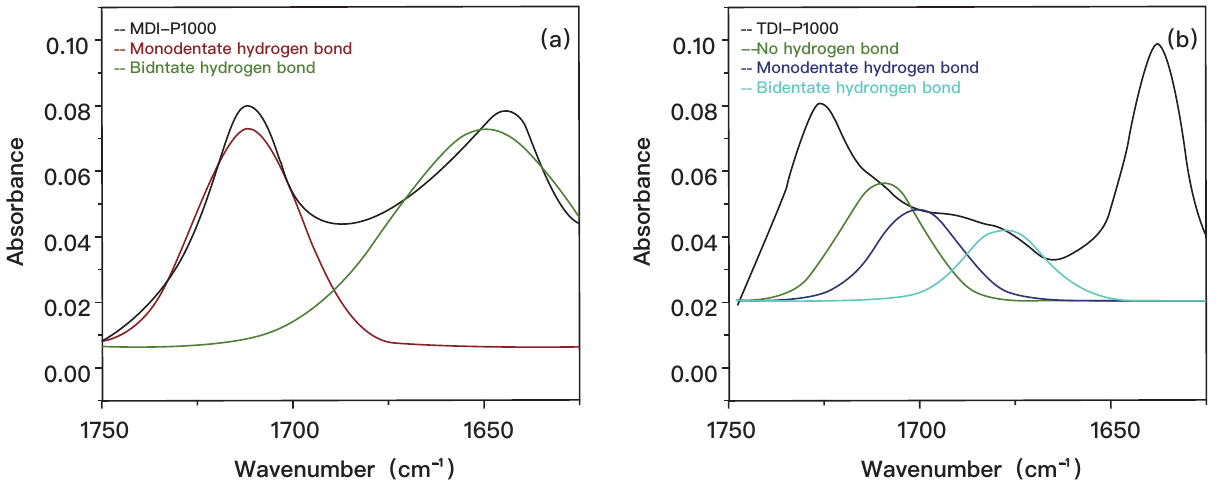
Figure 2. Application of Gaussian function into ATR-FTIR analysis of ( a ) MDI-P1000 and ( b ) TDI- P1000.